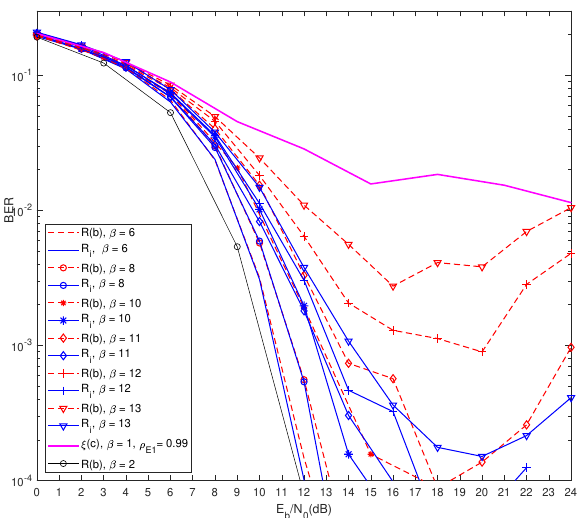
Figure 5. BER Performance of R ( b ) and R i with e E 1 R = 0.02, where R i denotes R ( b ) with an improved feedback loop in the IB-DFE receiver. feedback loop in the IB-DFE receiver.